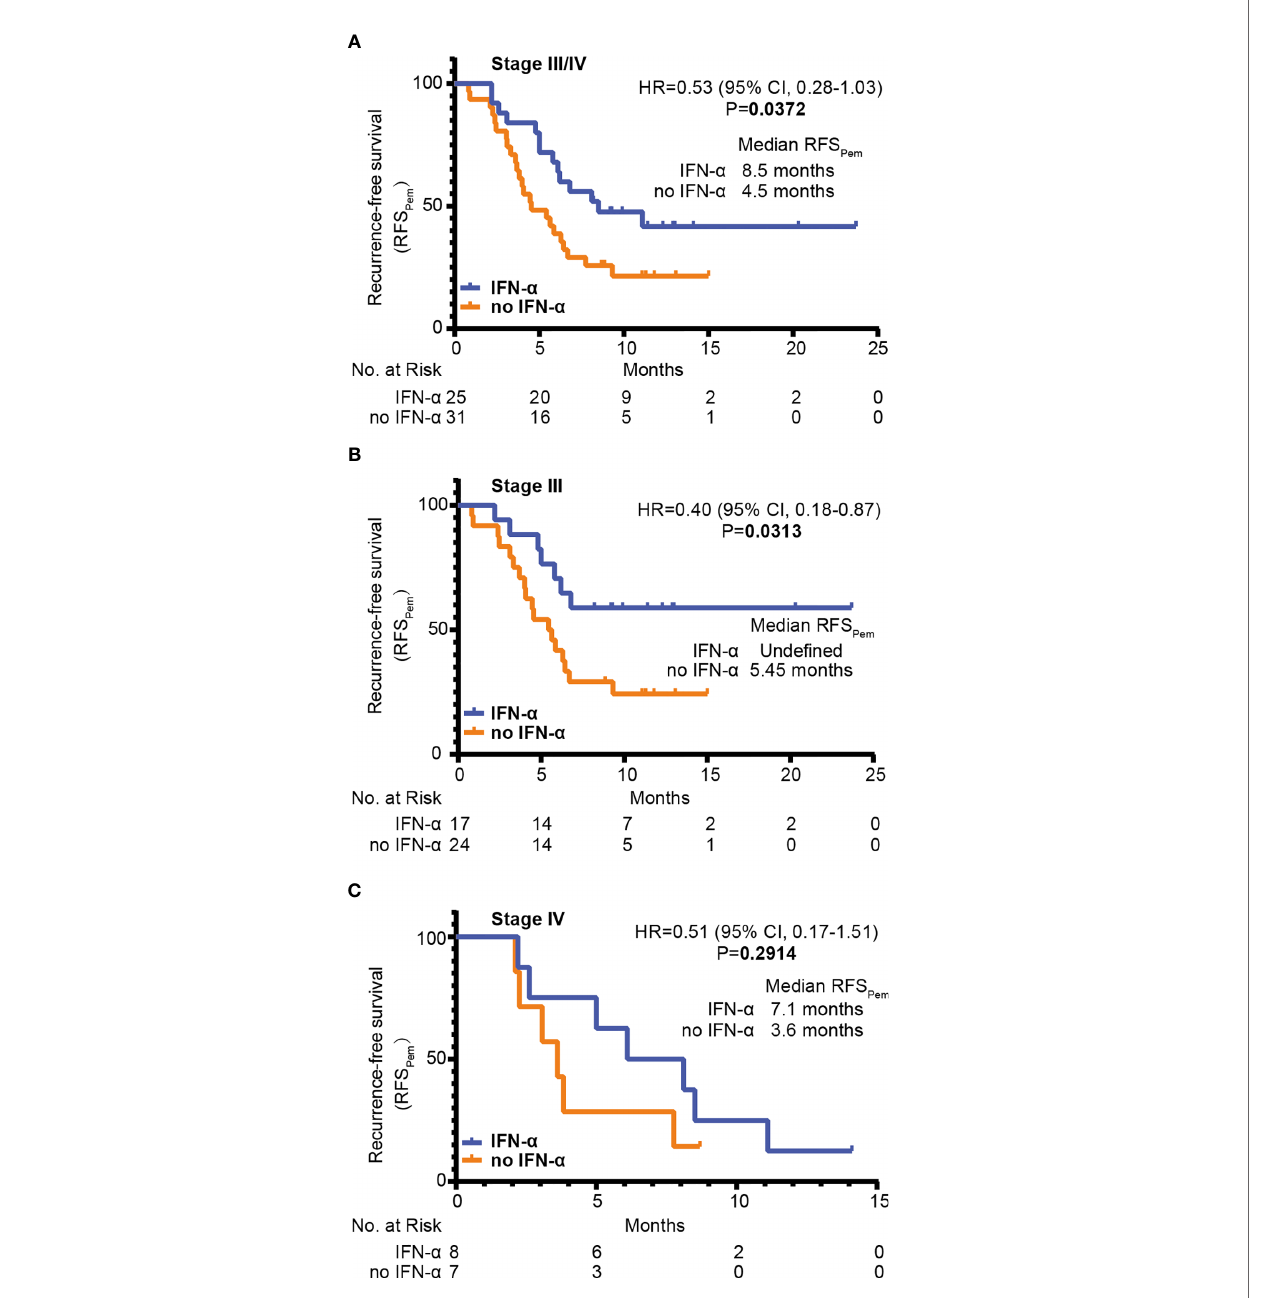
FIGURE 5 | The RFS Pem of patients was estimated with the Kaplan-Meier method. The numbers of patients at risk at each time point were shown below. Statistical analysis was performed by the Log-rank test between two groups. RFS Pem of all enrolled patients was shown in (A) RFS Pem of patients with stage III melanoma (n=40) was shown in (B) RFS Pem of patients with stage IV melanoma (n=16) was shown in (C) HR, hazard ratio; CI, con fi dence